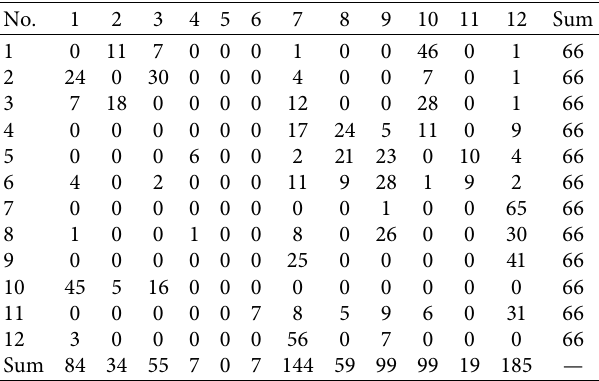
Figure 4: The province indexes with the largest or smallest node strength. (a) The largest node strength. (b) The smallest node strength. Table 5: Total number of the strongest edge between the indexes in rolling